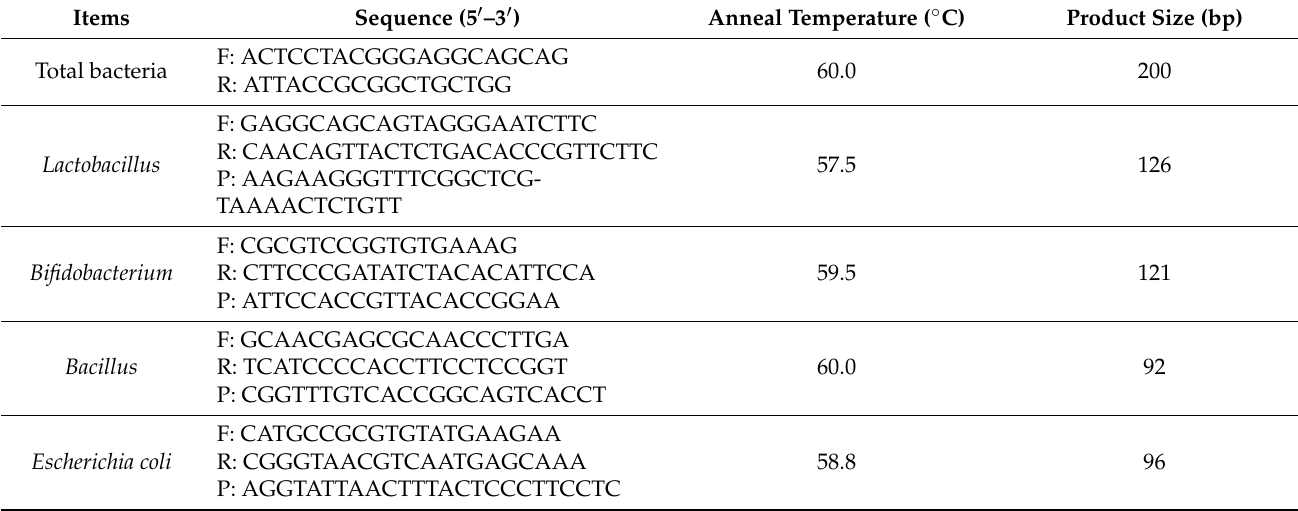
Table 4. Primer and probe sequences used for quantitative RT-PCR.